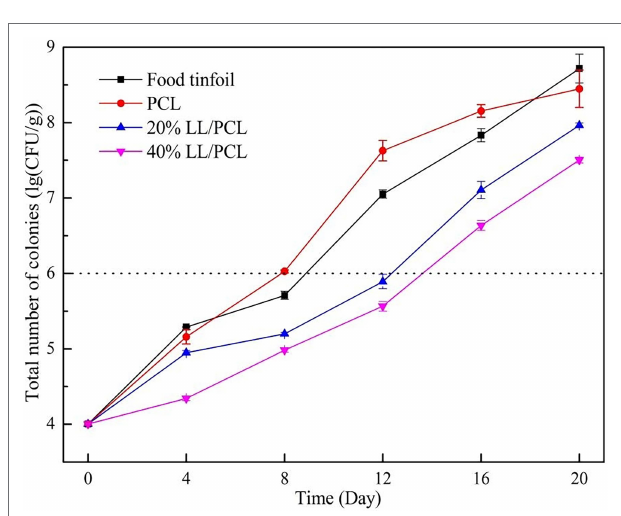
FIGURE 6 | Changes in total microbial count of